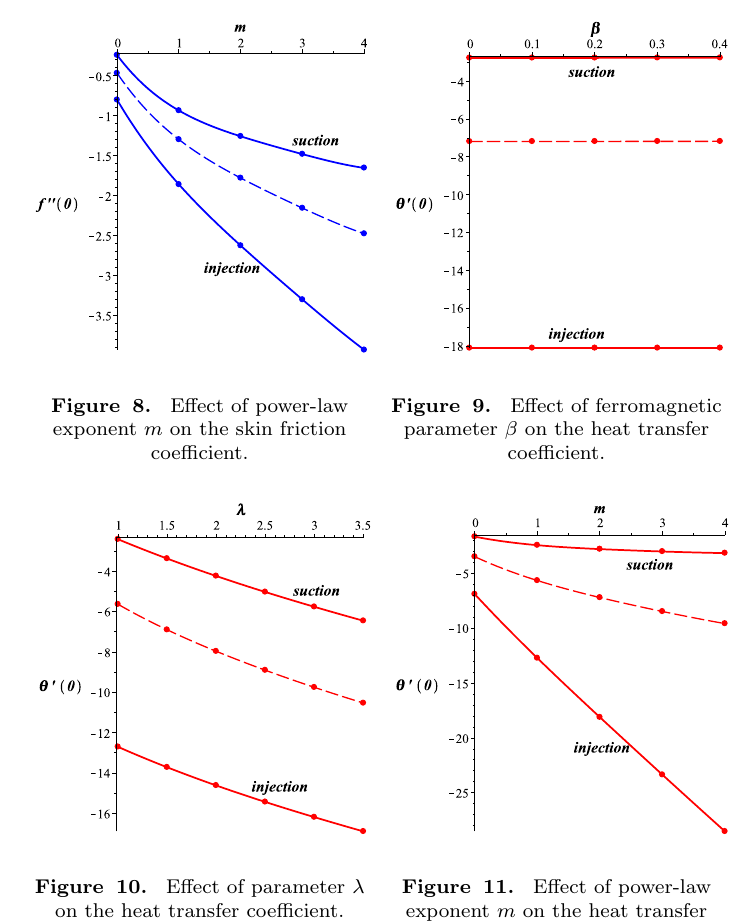
Figure 10. Effect of parameter λ on the heat transfer coefficient.